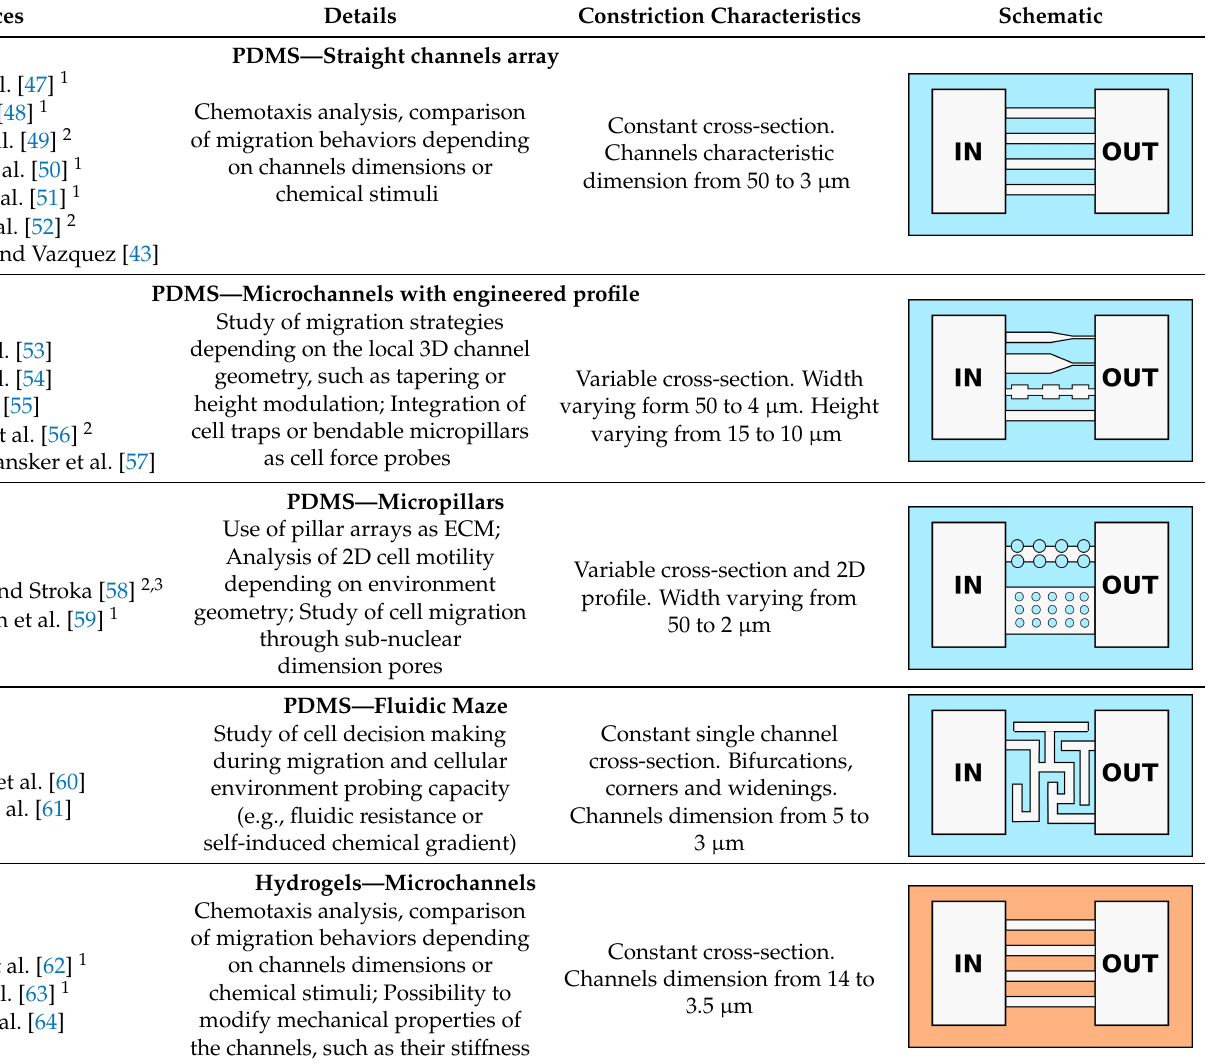
Table 1. Overview of the possible microfluidic cell migration assays